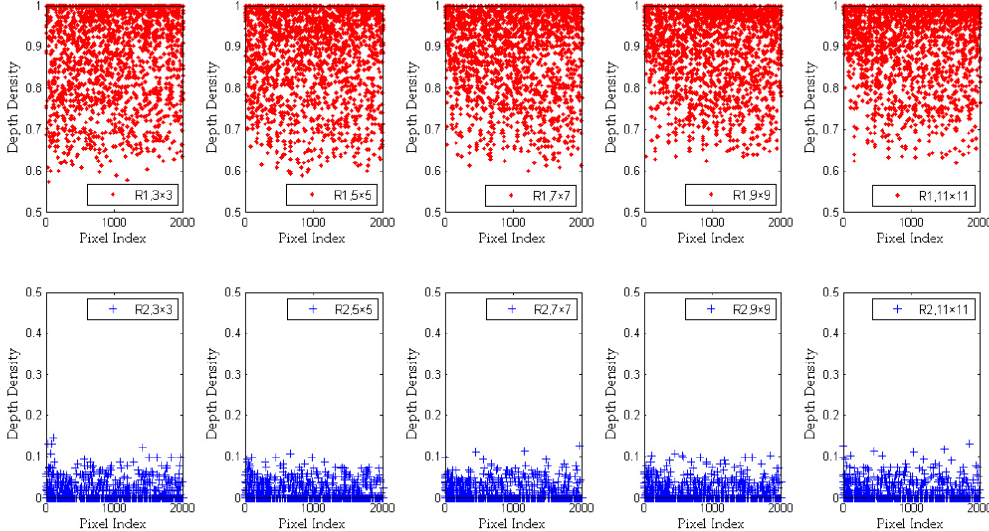
Figure 5. The depth density of all pixels in R1 and R2 using Equation (5). We set the size s to 3 × 3, 5 × 5, 7 × 7, 9 × 9, and 11 × 11, respectively. The depth density range of R1 is [0, 1]. The depth density range of R2 is [0, 0.5]. The pixel index represents the total number of pixels obtained by R1 or R2. In the region of R1, all pixels come from the surface of the same object. So we know that the adjacent pixels have similar values of depth. Therefore, when calculating 𝑑𝑑 (cid:3045),(cid:3030) , the values of 𝐺𝑠(cid:3435)𝑑 , 𝑑̅ , 𝜎(cid:3364) (cid:3439) , 𝐺𝑠(cid:3435)𝑑̅ , 𝑑̅ , 𝜎(cid:3364) (cid:3439) , 𝐺𝑠(cid:3435)𝑑 , 𝑑 , 𝜎′ (cid:3439) and 𝐺𝑠(cid:3435)𝑑 , 𝑑 , 𝜎′ (cid:3439) are close. So as shown (cid:3036),(cid:3037) (cid:3045),(cid:3030) (cid:3045),(cid:3030) (cid:3045),(cid:3030) (cid:3045),(cid:3030) (cid:3045),(cid:3030) (cid:3036),(cid:3037) (cid:3045),(cid:3030) (cid:3045),(cid:3030) (cid:3045),(cid:3030) (cid:3045),(cid:3030) (cid:3045),(cid:3030) from the top 5 graphs of Figure 5, the depth density value of R1 is distributed in the range [0.6, 1]. On